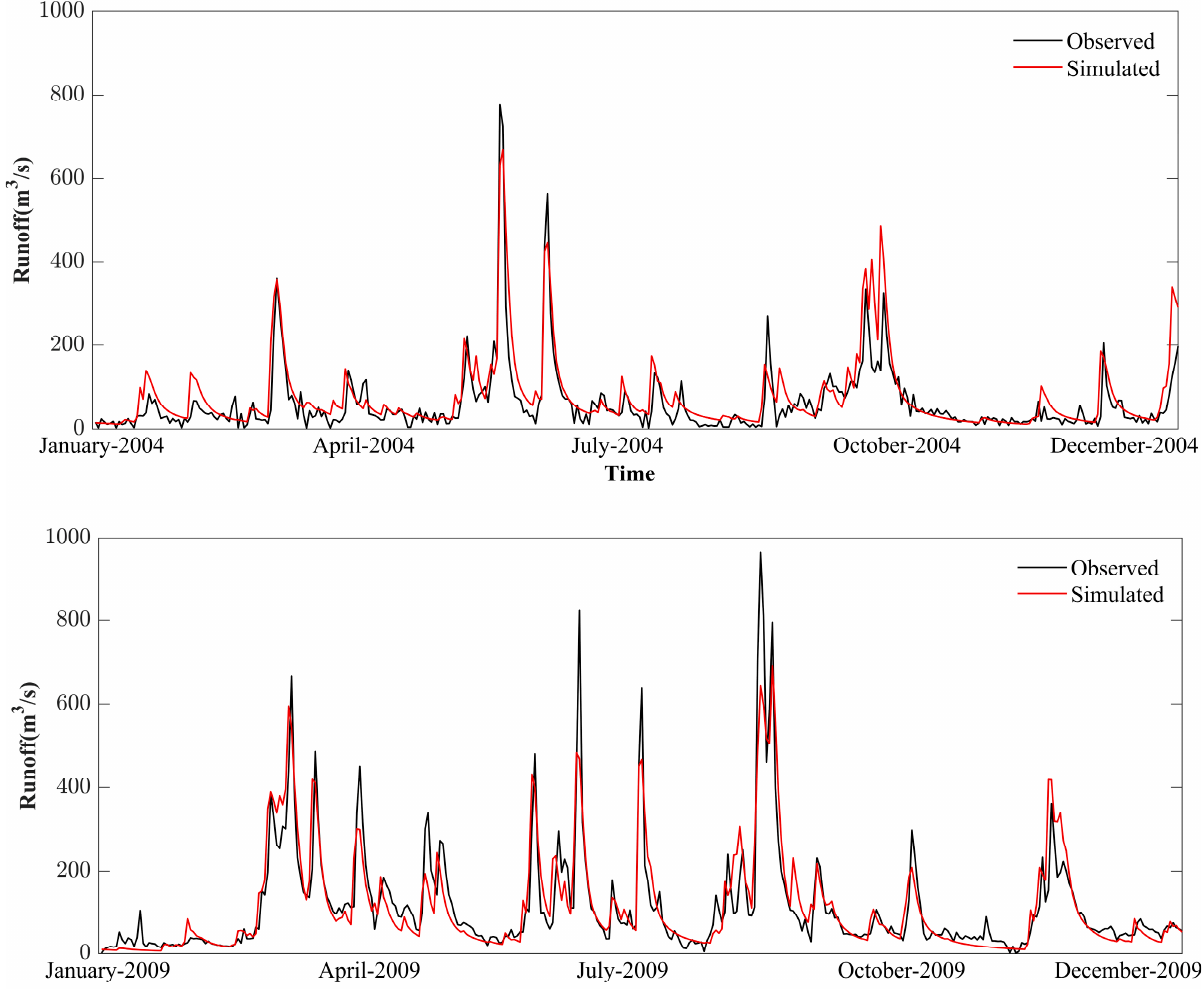
Figure 5. Comparison of observed and simulated daily runoff in the calibration (2004) and validation periods (2009) based on Scheme I.